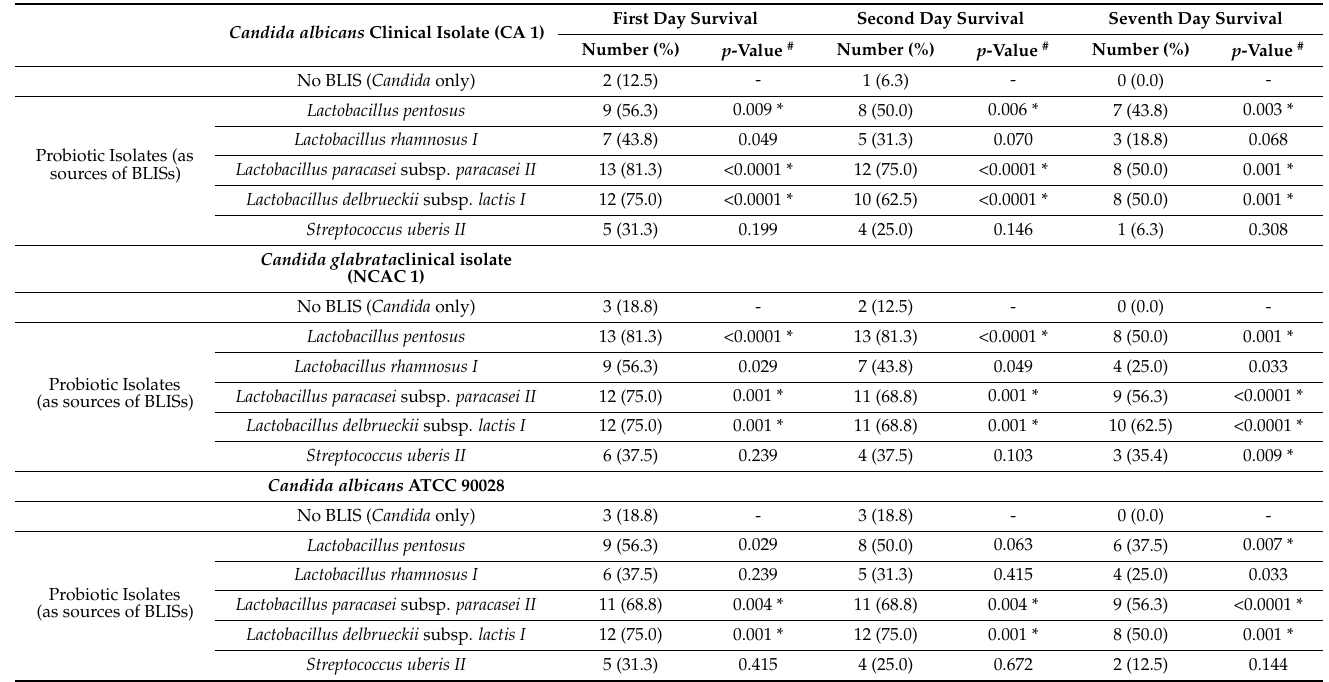
Table 5. Survival of Candida -infected Galleria mellonella treated with bacteriocin-like inhibitory substances (BLISs) on the first, second, and seventh